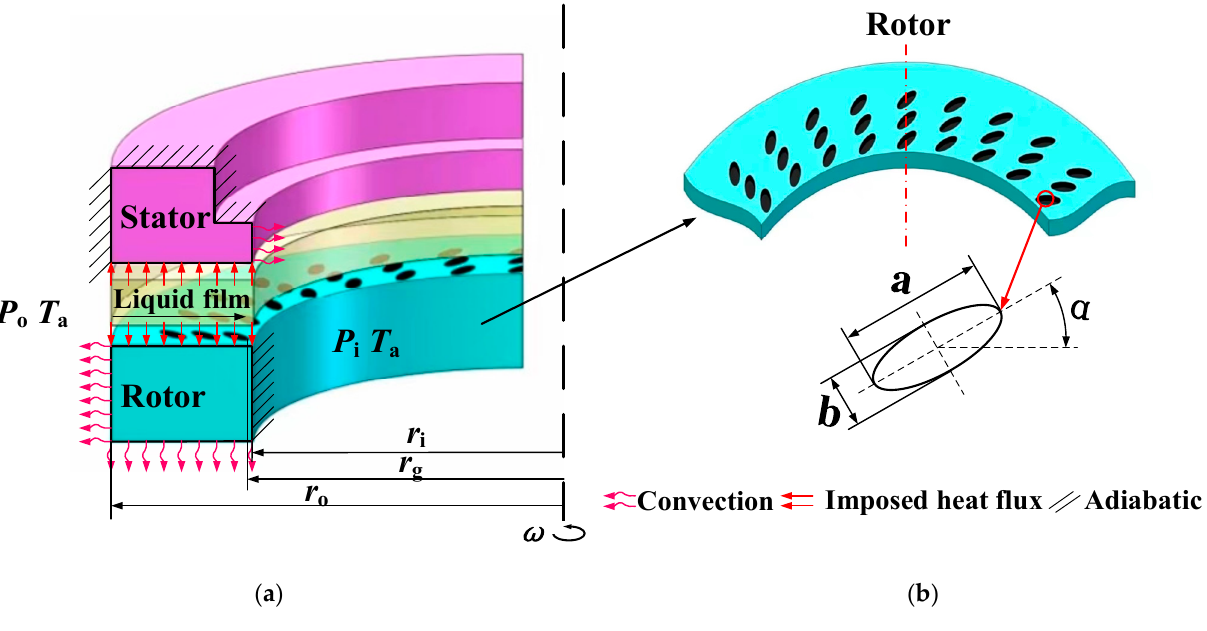
Figure 1. Schematic diagram of porous end face seal structure and boundary conditions. ( a ) sealing structure, ( b ) surface groove and boundary condition. Table 1. Structure parameters of the microporous texture.